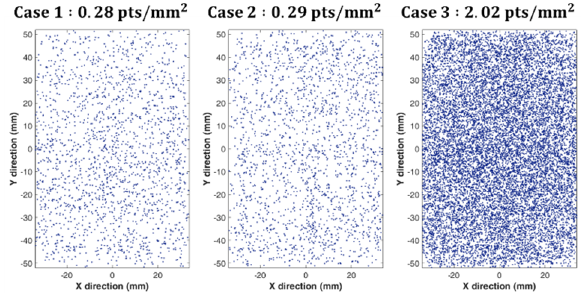
Figure 3. Overlaying all image points of all used images in the image frame